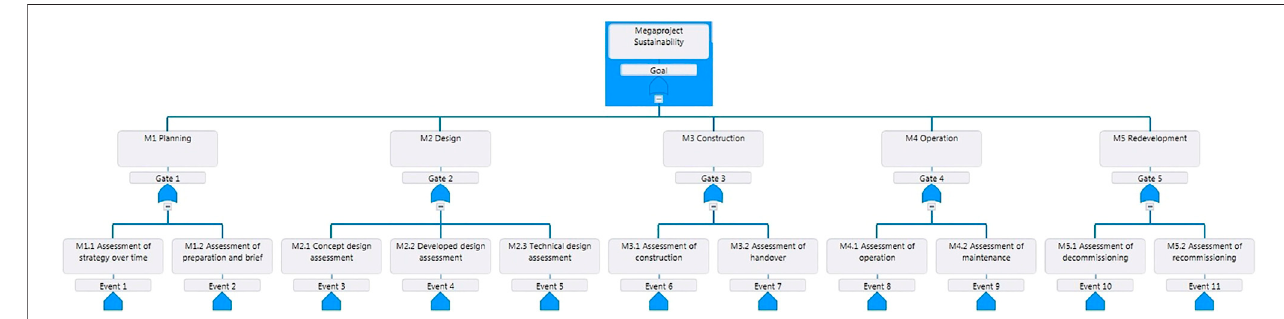
FIGURE 3 | An event tree diagram for megaproject sustainability